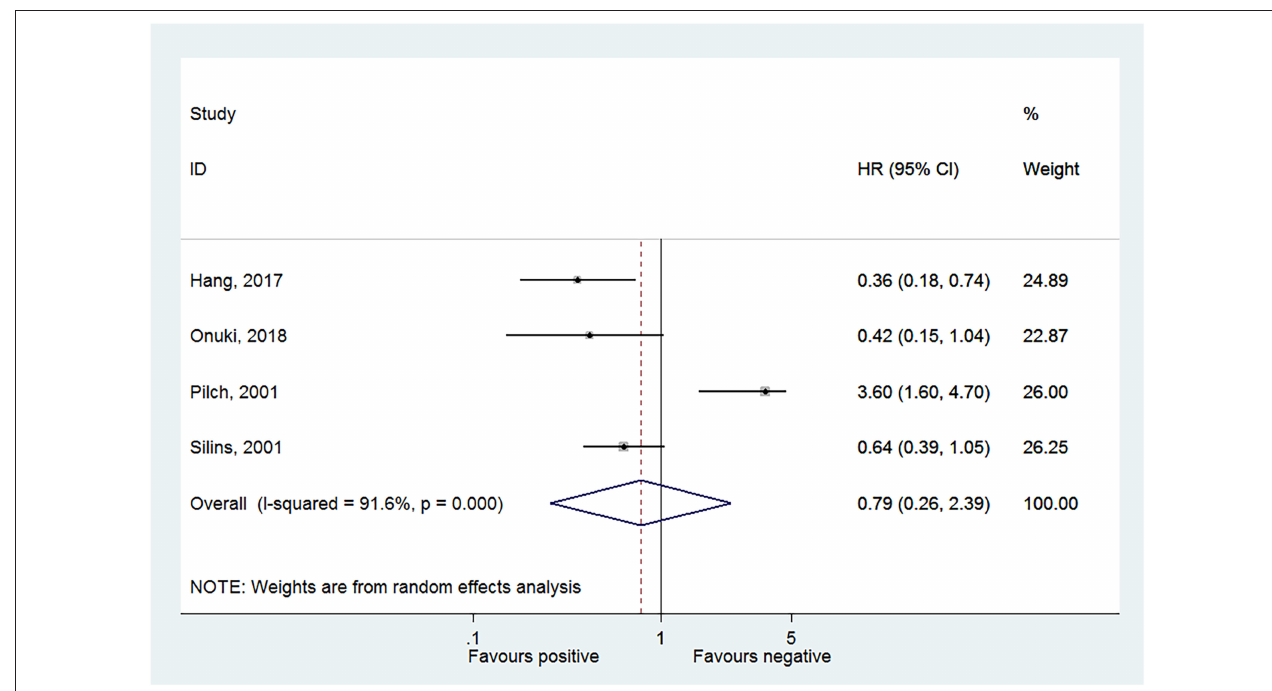
TABLE 2 | Results from the meta-analysis. HPV genotype positive vs. negative. N HR (95% CI) P I -square P (Heterogeneity)